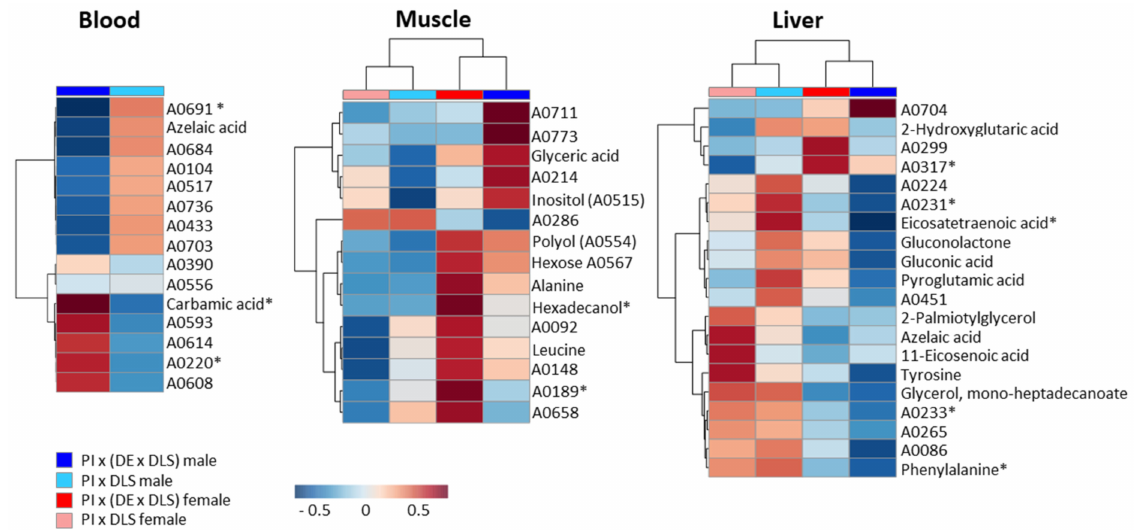
Figure 5. Heatmaps of features varying between genotypes. Displayed are the normalized (median normalization, unit variance scaled) ion intensities for relevant molecular features. Features that were significantly different by Tukey HSD/Steel- Dwass Test are labelled with [*]. All other features were obtained by Students T-Test/Wilcoxon Test, and are designated as most likely different. Supplementary Table S2 contains the corresponding values for log2 fold changes and p